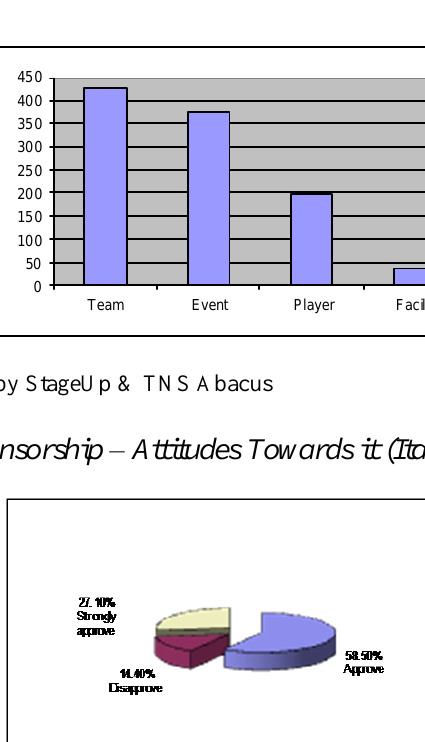
Figure 6: Breakdown of Sport Sponsorships in Italy by Type – 2003 (in Millions of Euros)